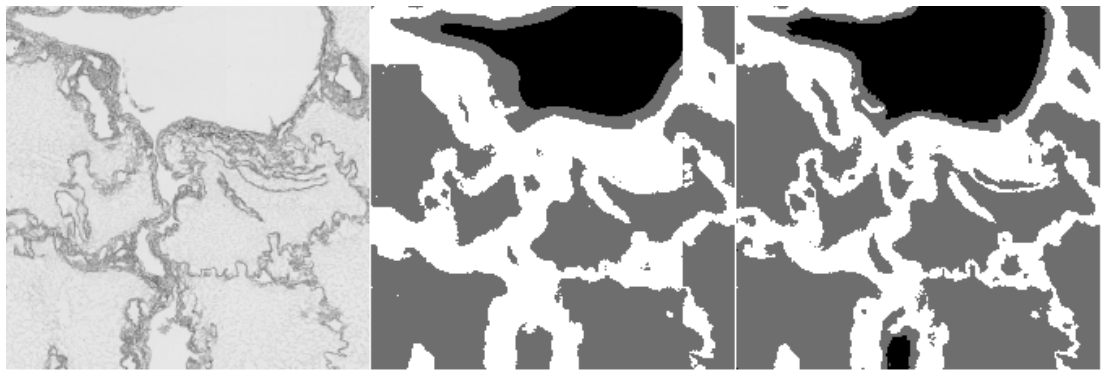
Figure 6. Example of semantic segmentation, where the neural network reached better results. The original image (on the left ), the result from the HCTFS (in the middle ), and the results from the neural network (on the right ).